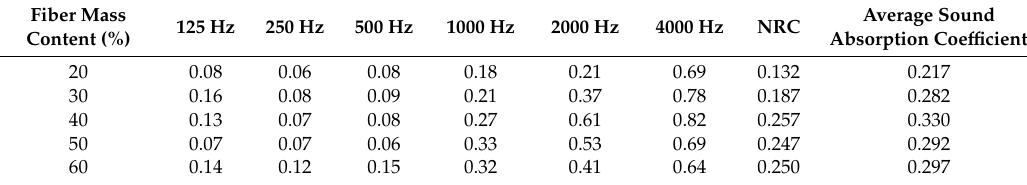
Table 2. Noise reduction coe ffi cient (NRC) and average sound absorption coe ffi cient for varied fiber mass content samples (15 mm thickness and 300 kg / m 3